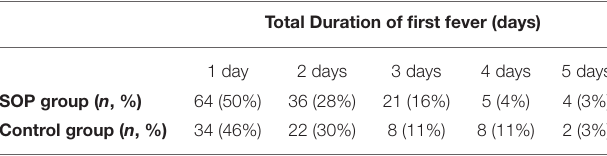
TABLE 2A | Prevalence of fever with number of patients in SOP and control groups.